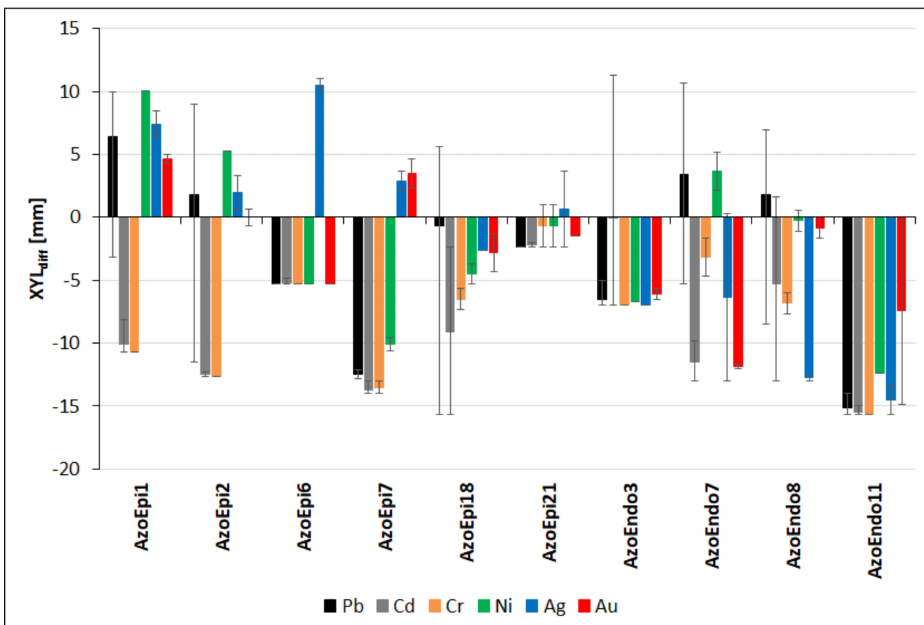
Figure 7. Effect of the metals applied in the specified range of doses (in mg L − 1 ) on the xylanolytic activities of the selected strains expressed as differences in the size of halos (in mm) vs. the untreated control. Positive values of bars—stimulation of the activity; negative values of bars—inhibition of the activity. Positive whisker—maximum difference; negative—minimum. See Table 1 for strain